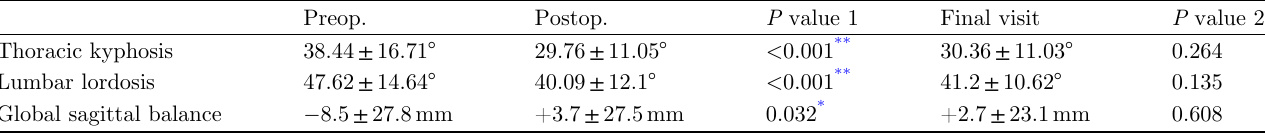
Table 3. Sagittal parameters.